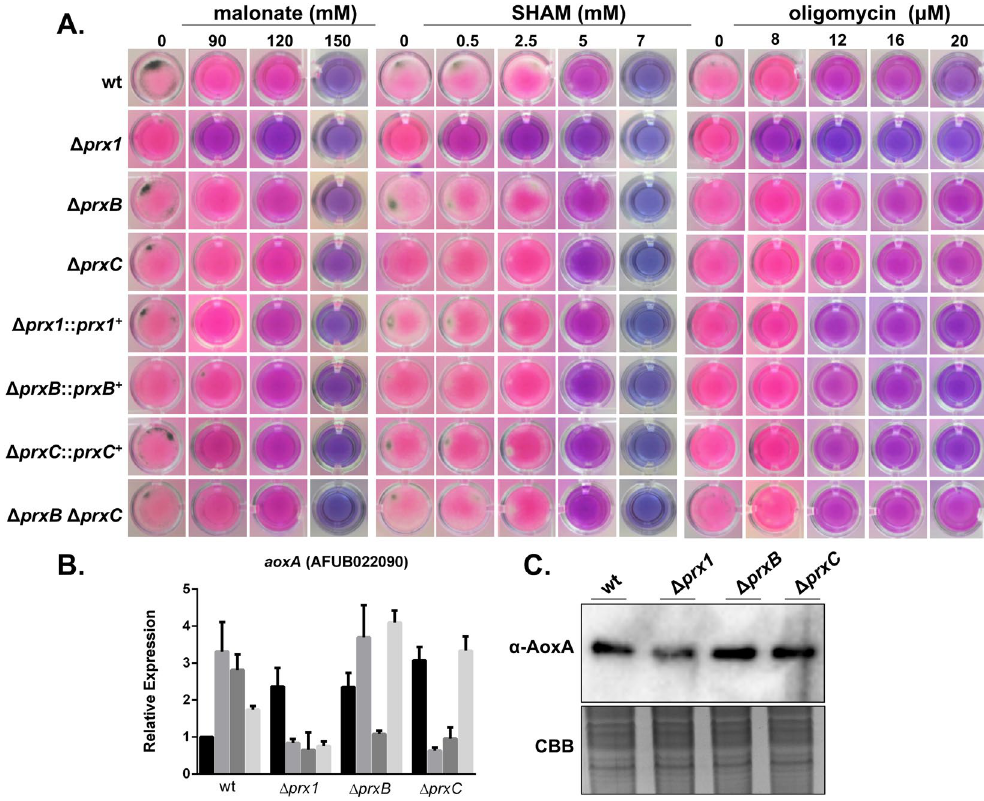
Figure 8. A . fumigatus Prx deletion mutants are sensitive to pharmacological inhibitors of the electron transport chain. ( A ) Viability of the germlings of the wild-type and Prx mutants in the presence of malonate, SHAM and oligomycin. Viability is shown by the indicator Alamar blue. Plates were incubated at 37 °C for 48 h and then photographed. A bluish color indicates decreased mitochondrial activity and therefore, lower viability. ( B ) Expression analysis of aoxA in the Prx null mutants in the presence of paraquat. The fold increase represents the normalized mRNA abundance relative to the wild-type strain. The data represent the average value of three biological replicates, Bar = SD, * p ≤ 0.05. ( C ) Western blot for AoxA expression. Anti-AoxA was used to detect the total amount of AoxA (40.8 kDa) in the mitochondrial extract. A Coomassie Brilliant Blue (CBB) stained gel was used as a loading control for the mitochondrial enrichment. Experiments were run in triplicate with similar results. Image was cropped from that shown in Supplementary Figure